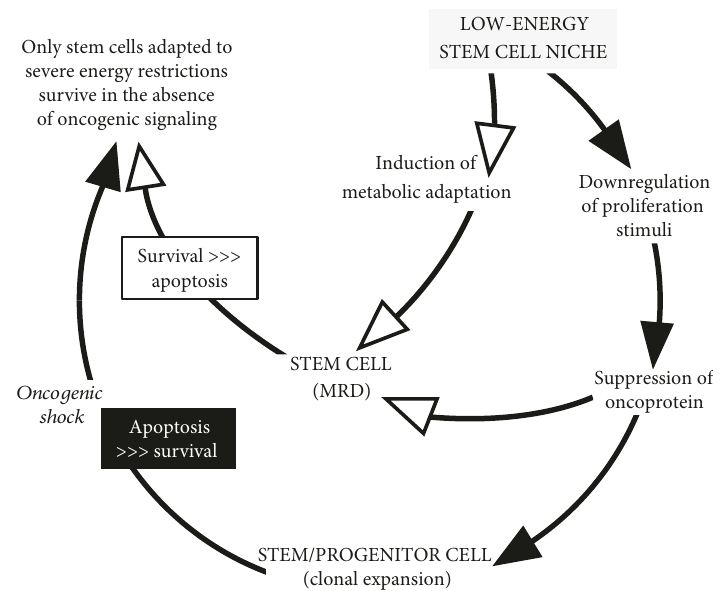
Figure 3: Metabolic adaptation lets stem cell escape oncogene addiction and oncogenic shock. Suppression of oncogenic signalling is necessary to prevent stimuli driving commitment to clonal expansion and di ff erentiation from antagonizing the long-term maintenance of stem cell properties in the SCN. Oncogene suppression puts under stress (black arrowheads/box) stem/progenitor cells committed to clonal expansion and di ff erentiation, which are oncogene-addicted. Thus, in the SCN, these cells would be subjected to prevalent proapoptotic stimuli and undergo the “ oncogenic shock. ” On the contrary, stem cells which metabolically adapt to SCN environment become independent of oncogene signalling (lose oncogene addiction) and escape oncogenic shock (white arrowheads/box), ensuring MRD